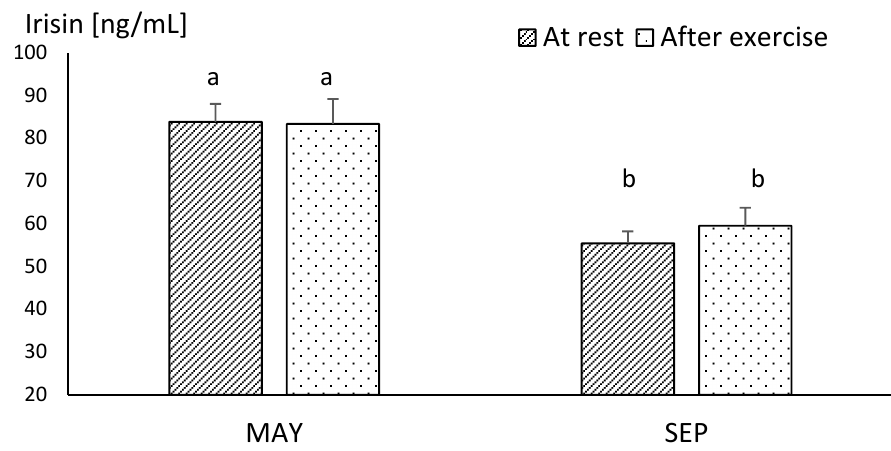
Figure 1. The mean values of plasma irisin concentration in racehorse at the beginning (MAY) and in the end (SEP) of the training season. Error bars represent standard errors ( n = 10). a,b—different letters indicate significant differences ( p ≤ 0.001).